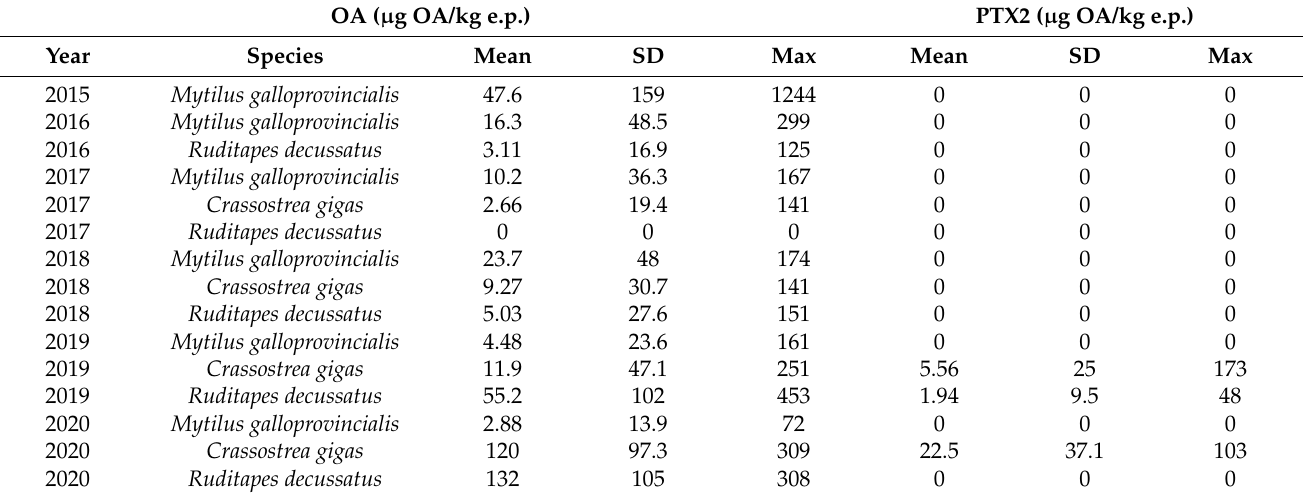
Table 6. Concentrations of OA and PTX2 determined in bivalve mollusks from Tortol ì Lagoon during 2015 to 2020. OA ( µ g OA/kg e.p.) PTX2 ( µ g OA/kg e.p.)